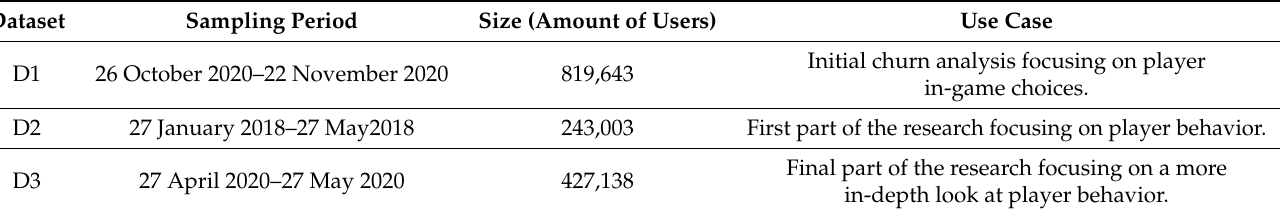
Table 1. Dataset D1, D2, and D3